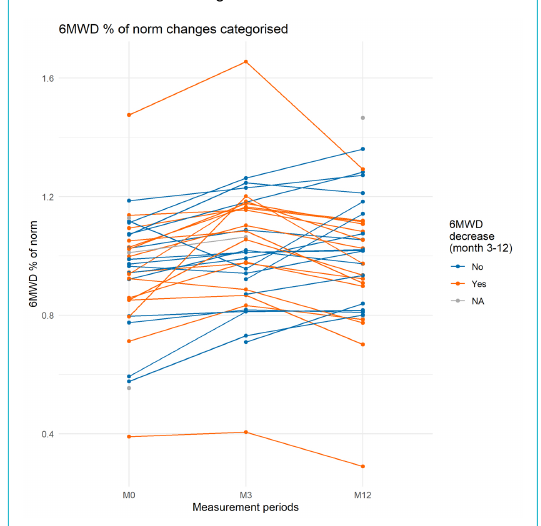
Figure 3: Individual changes in 6MWD percentage predicted norm (% of norm) for first evaluation (M0), 3-month follow-up (M3) and 12-month follow-up (M12). Individuals with decreases in 6MWD >30 m are colored in orange.